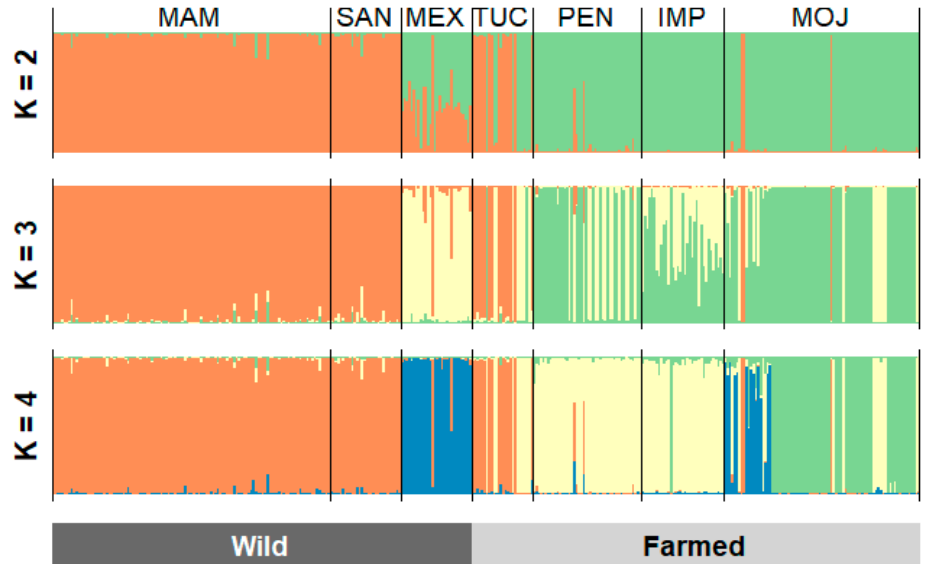
Figure 3. Standard population structure of three wild and four farmed populations of Arapaima gigas . The analysis based on 12 ‐ loci microsatellite markers, supported by STRUCTURE, indicated the existence of two groups (K = 2). MAM—Mamirauá; SAN—Santarém; MEX—Mexiana; TUC—